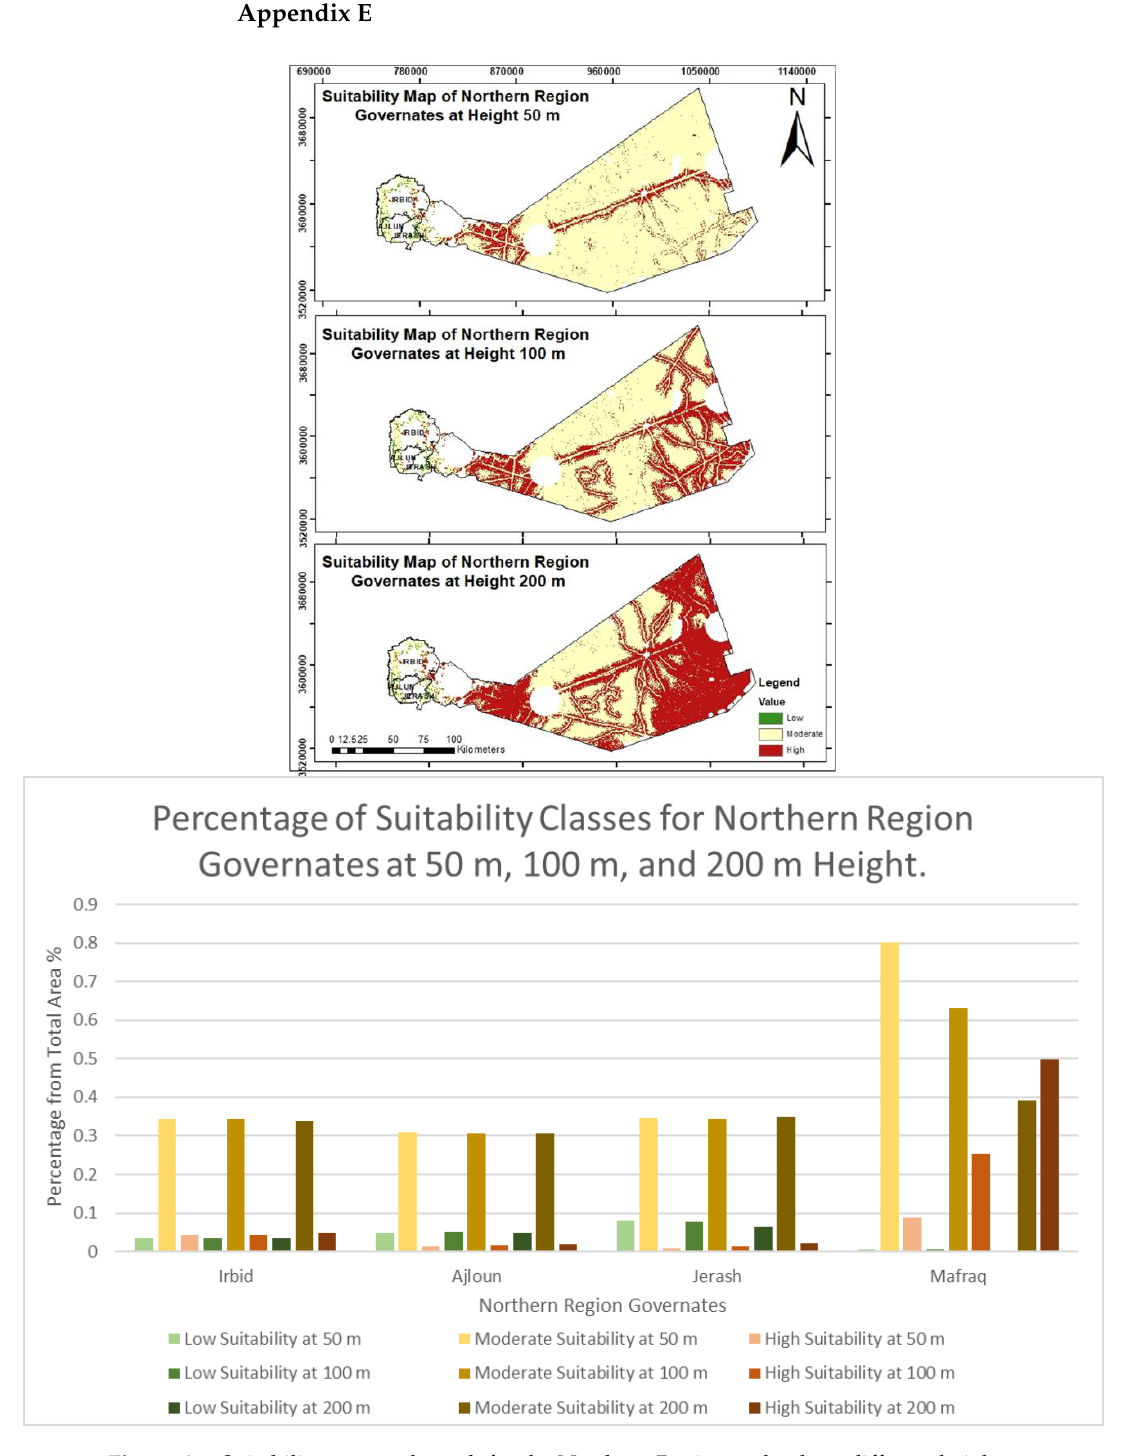
Figure A3. Suitability map and graph for the Northern Region at the three different